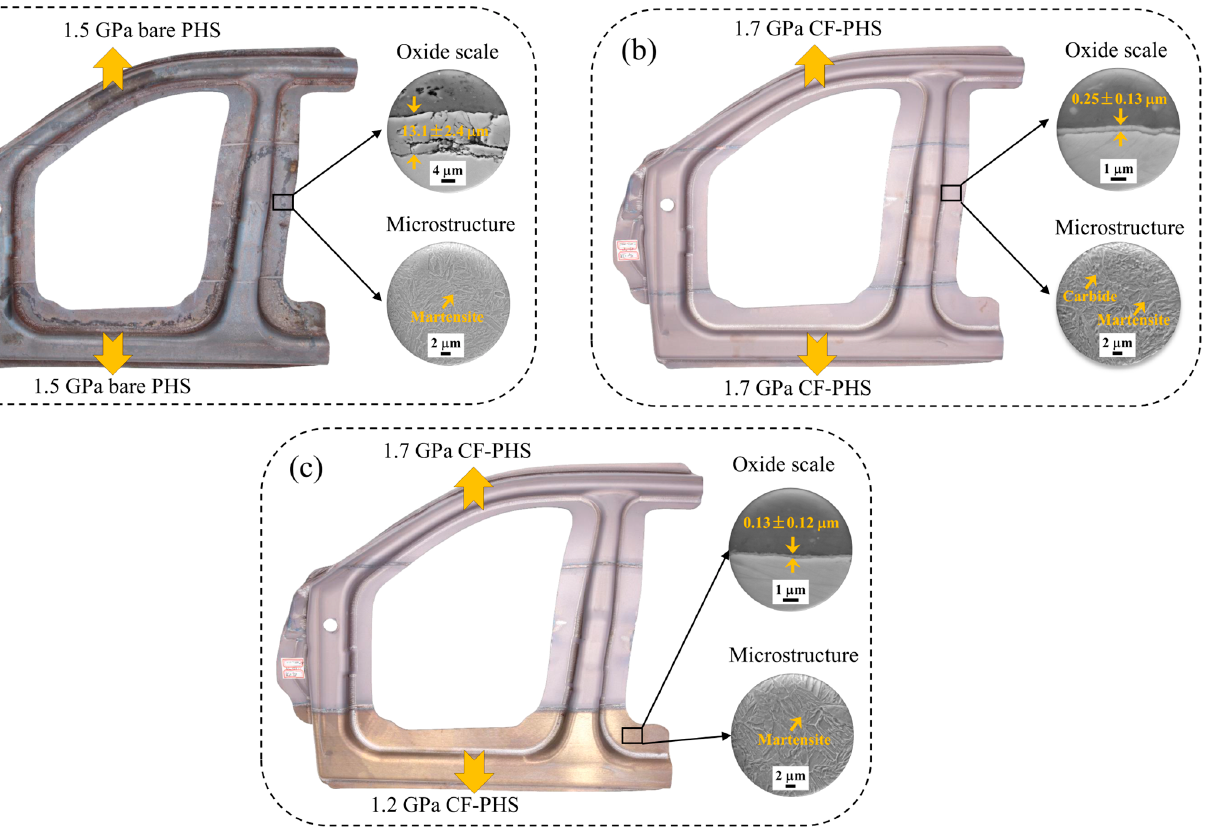
Figure 12. Tailor-welded blanks after hot forming of ( a ) bare PHS with 1.5 GPa/1.5 GPa and CF- PHSs with ( b ) 1.7 GPa/1.7 GPa and ( c ) 1.7 GPa/1.2